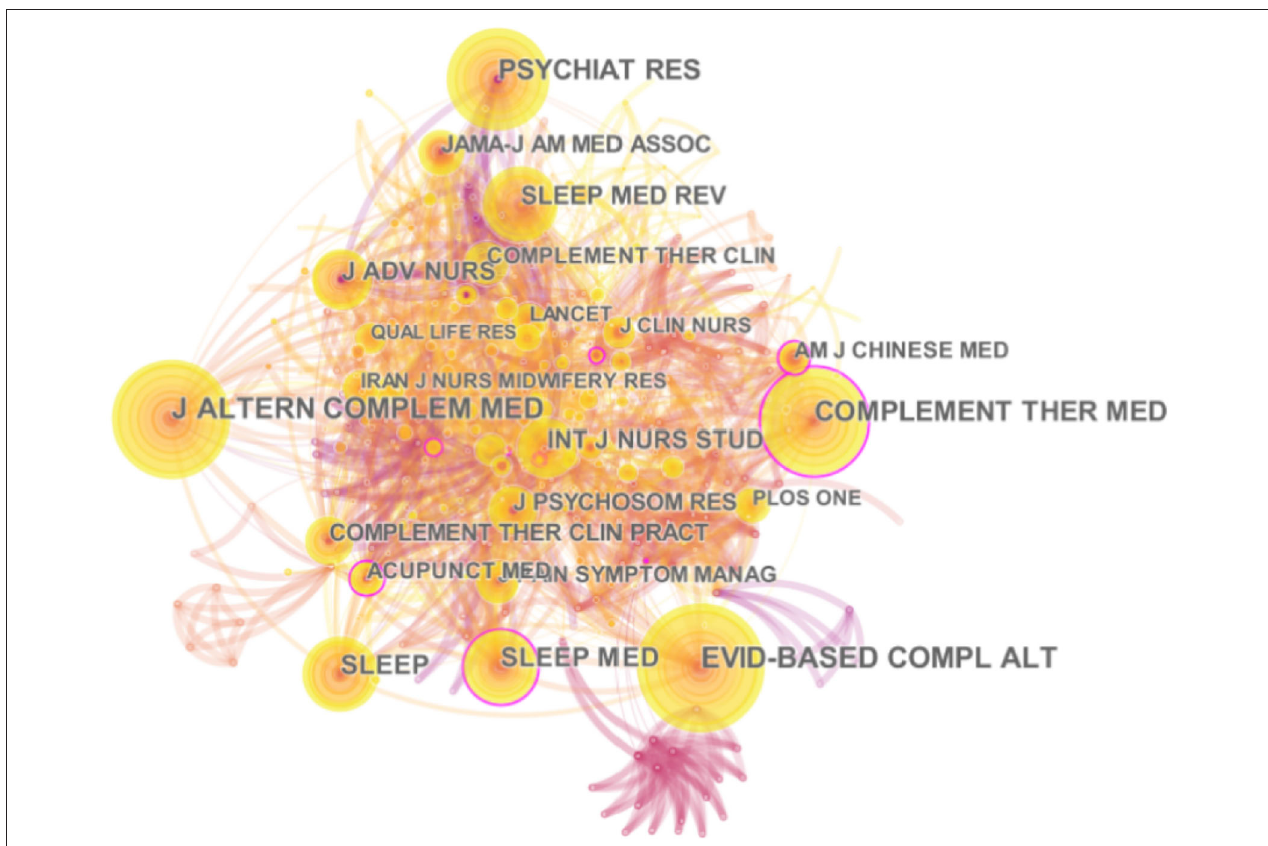
FIGURE 3 | Network map of cited journal.